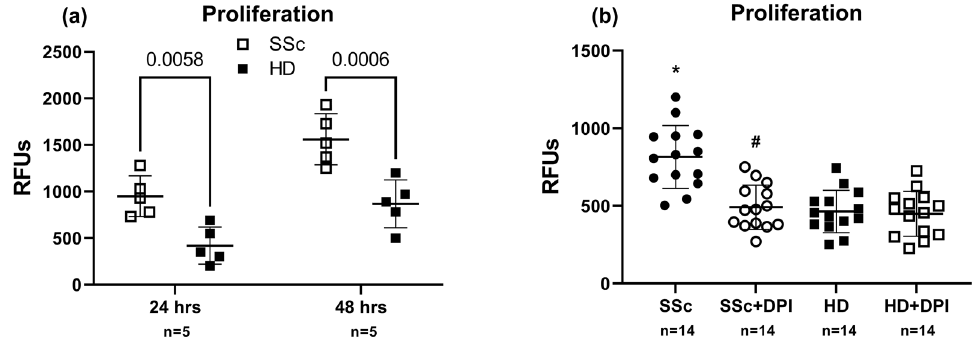
Figure 2: E ff ect of SS sera on HPMECs proliferation: ( a ) SSc sera induce HPMECs proliferation. Subcon fl uent HPMECs were cultured for 24 and 48 h in basal medium containing 10% ( v/v ) of sera from SSc patients and healthy donor. ( b ) SSc sera - induced proliferation increase in HPMECs is mediated by NADPH oxidases. Subcon fl uent HPMECs were cultured for 48 h in basal medium containing 10% ( v/v ) of sera from SSc patients and healthy donor. In selected experiments, cells were incubated for 1 h with 5 µM of the NADPH oxidase inhibitor DPI before exposure to the sera. Fluorescence data were normalized for protein content and expressed as mean ± SD of the RFUs. ( a ) Horizontal lines indicate the mean value and standard deviation range. Two - way analysis of variance, followed by a post hoc Š ídák ’ s test for multiple comparisons, was used to detect di ff erences among studied groups. ( b ) Horizontal lines indicate the mean value and standard deviation range. Kruskall – Wallis one - way analysis of variance, followed by a post hoc Dunn ’ s test for multiple comparisons, was used to detect di ff erences among studied groups. * p ≤ 0.0004, signi fi cantly di ff erent from the control group ( HD ) ; # p ≤ 0.002, signi fi cantly di ff erent from the SSc group.